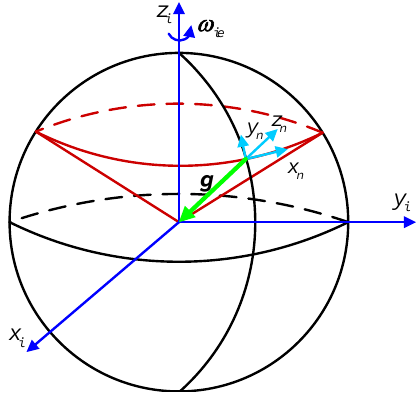
Figure 1. Moving trajectory of gravity vector in the inertial